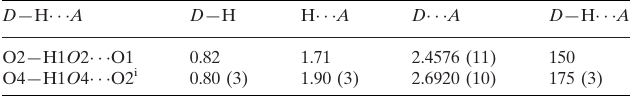
Hydrogen-bond geometry (A˚ , (cid:2)